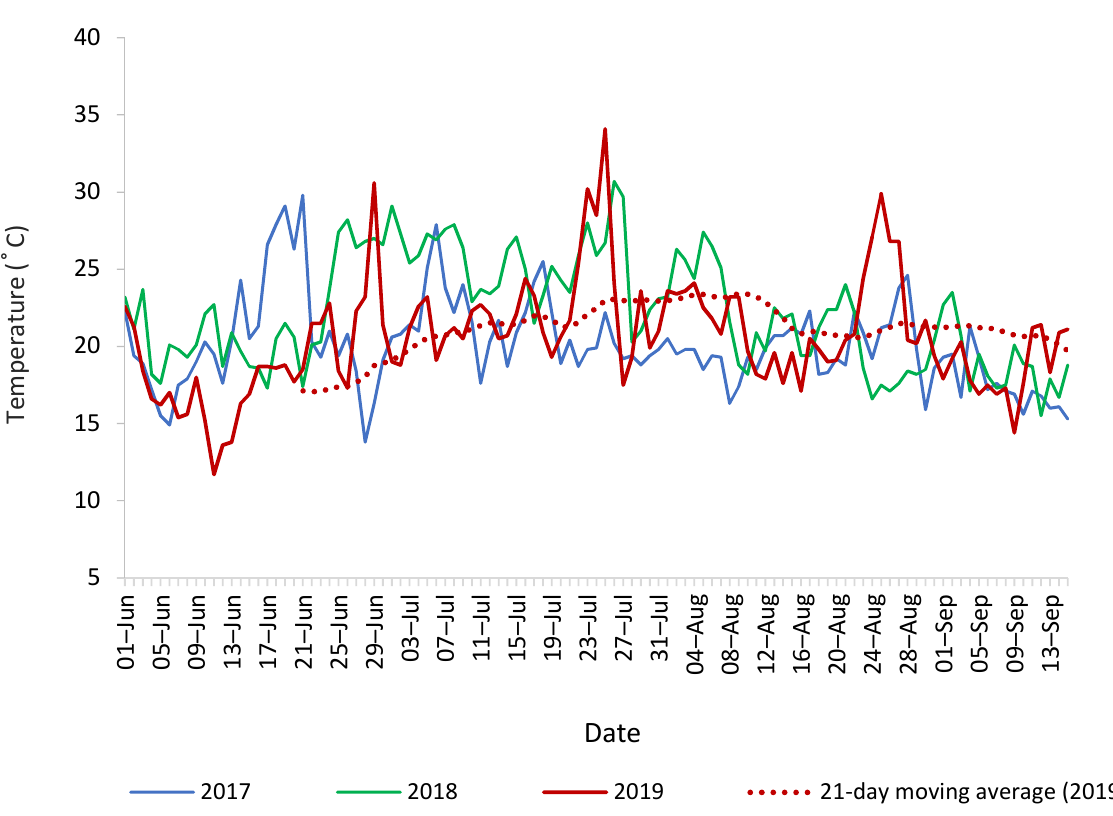
Figure 4. Maximum temperatures during the summer period (1 June to 15 September) for 2017, 2018 and